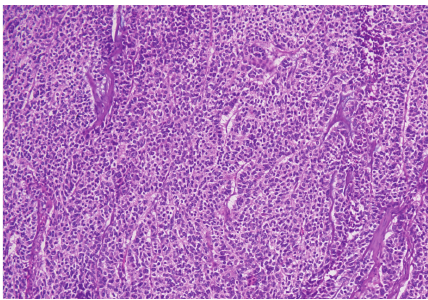
Figure 4: Well-differentiated neuroendocrine tumor; tumor cells arranged in trabeculae, cords, and lobules with vascular septa. These cells show mild nuclear atypia, fine stippled chromatin, inconspicuous nucleoli, and moderate amount of eosinophilic granular cytoplasm. Mitosis is infrequent (H&E